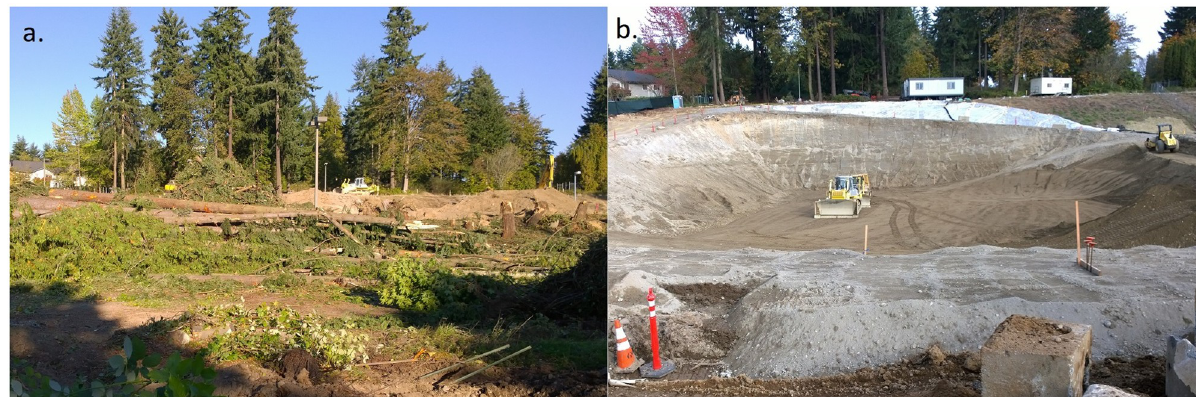
Fig 1. Commercial development project located in Redmond, Washington. Depicted: a. clearing the site of vegetation and b. grading the site and digging the foundation. Photo credit: K. Dyson.